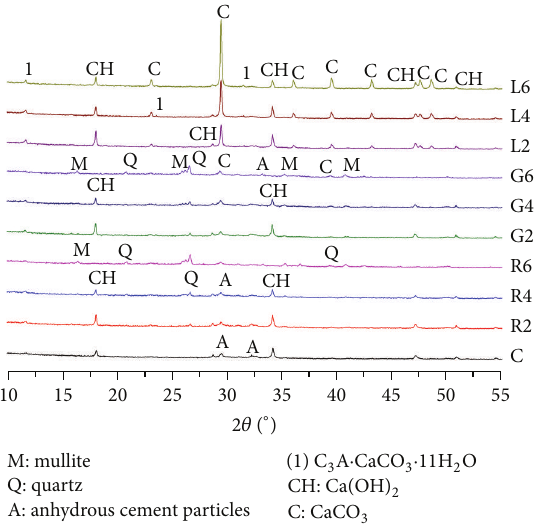
Figure 8: XRD patterns of specimens at 90 d.